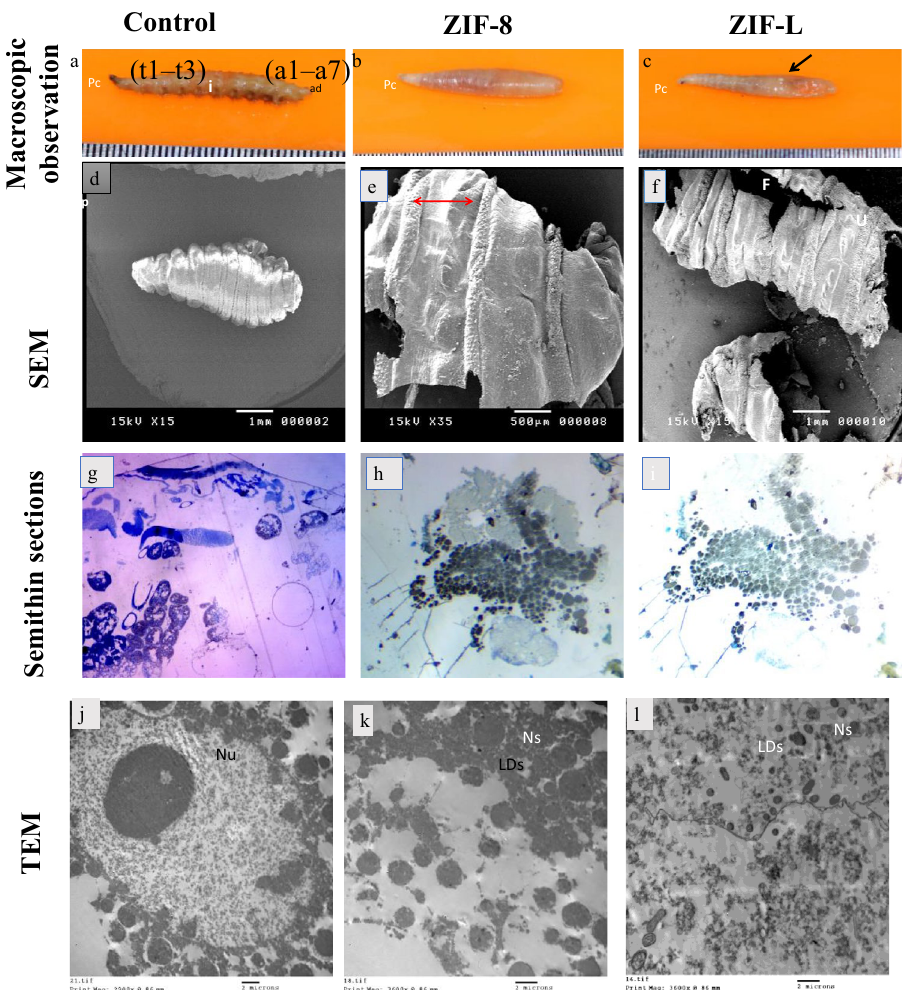
Figure 6. Photographs, showing ( a ) larvae of Sarcophaga sp., ( b ) from group: a, group (1) control, Larvae elongated, truncated posteriorly and tapering toward the anterior extreme curved downward, they are cylindrical, segmented. The body is divided into pseudocephalon (pc), three thoracic segments (t1–t3), seven abdominal segments (a1–a7) and an anal division (ad), which carries the posterior spiracle, intestine (i), ( c ) from group (2) Larvae were normally bloated, had a rotten stench, and d: from group (3) Larvae were completely bloated, a strong putrid odor with fluids oozing and the presence of abscess (row). Scanning electron micrographs showing: ( a ) The whole body, ( d ) group (1) control, Showing ventral view showing pseudocephalon (PC), anterior spiracles (as) the posterior spiracles (Ps.), well developed annular bands (ab) of intersegmented spines, is in 4–6 rows of pinted spines, the grooves of the body are obvious, ( e ) group (2) larva showing broken with hyperplasia of the skin epithelial layer, ( f ) group (3) larva showing broken, dryness of the skin with formation of ulcer(u)and ( k ) the presence of fissure (F) .Photomicrographs of semithin sections of the frontal part Sarcophaga sp. Larvae, ( g ) group (1), ( h ) group (2) and ( i ) group (3). Transmission electron microscopy (TEM) micrographs of anterior part of Sarcophaga sp. Larvae, ( j ) group (1), ( k ) group (2) and ( l ) group(3).nucleus (Nu) , mitochondria (M), numerous lipid droplets (LDs), naopartecticles